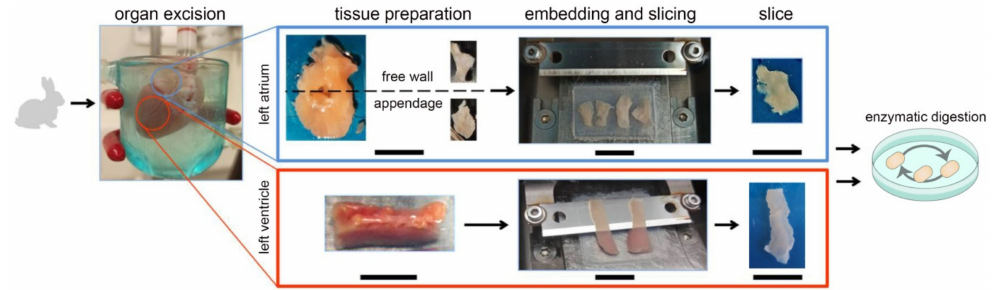
Figure 1. Overview of the protocol for the preparation of tissue slices and CM isolation from rabbit left atrium ( top ) and left ventricle ( bottom ), scale bars 10